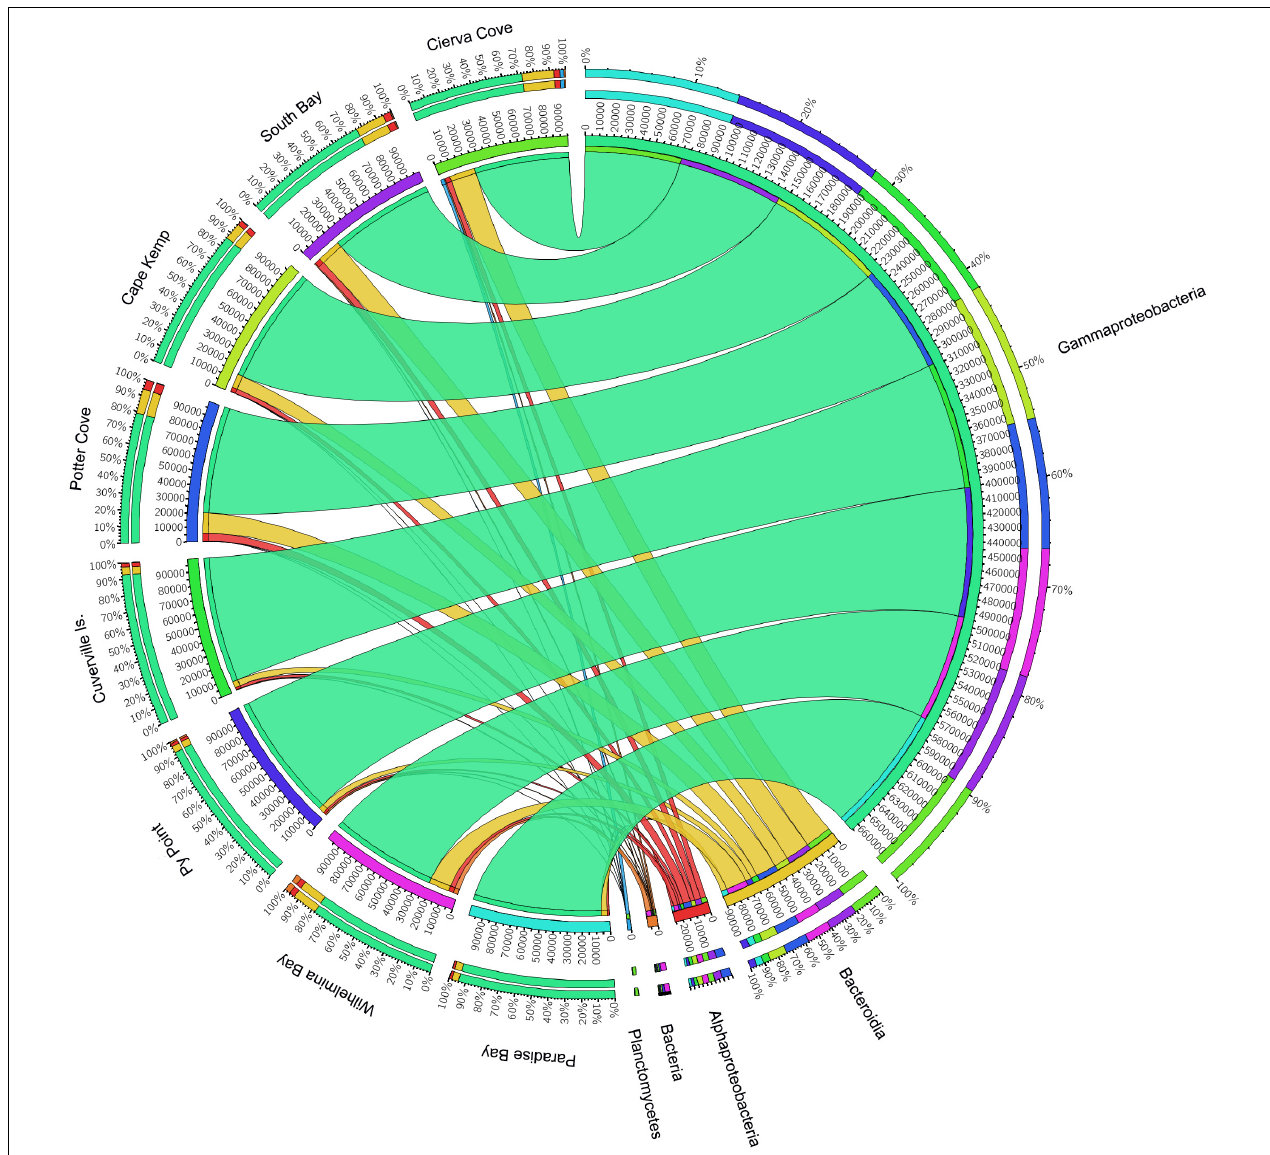
FIGURE 2 | Relative abundances of microbial groups (class level) associated with the sponge M. acerata sampled at different sites along the WAP. The circos plot displays the relative abundance of prokaryotic classes from M. acerata samples collected at the different localities. The plot was generated from the OTU table grouped by class with at least 1% of relative abundance in at least one sponge sample. Values were multiplied by 1,000 and rounded without decimals in order to perform the circos plot analysis. The relative abundance of each class is directly proportional to the width of each ribbon connecting prokaryotic taxa to its respective sample. Each class is assigned a specific colour. The inner ring represents the total relative abundances (multiplied by 100) for a specific taxon and the proportion assigned to each locality. The outer ring represents the percentage of each taxon assigned to each locality.